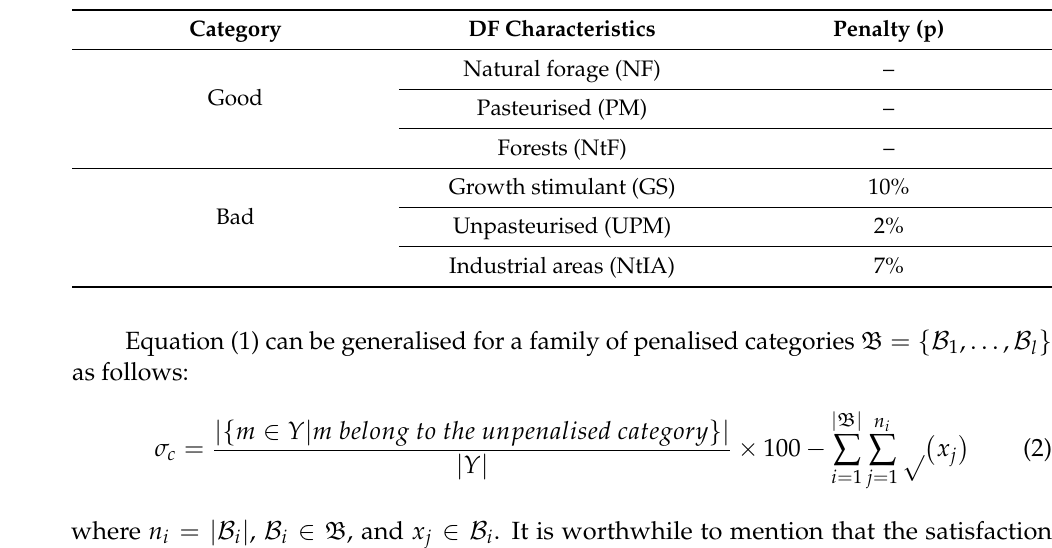
Table 3. An example of categorising the DF